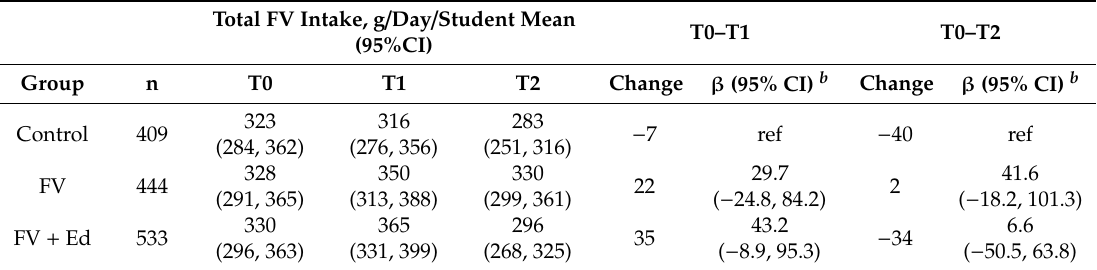
Table 5. Short- and long-term intervention e ff ects on children’s FV intake (gram / day / student) for the total sample ( n = 1386) a